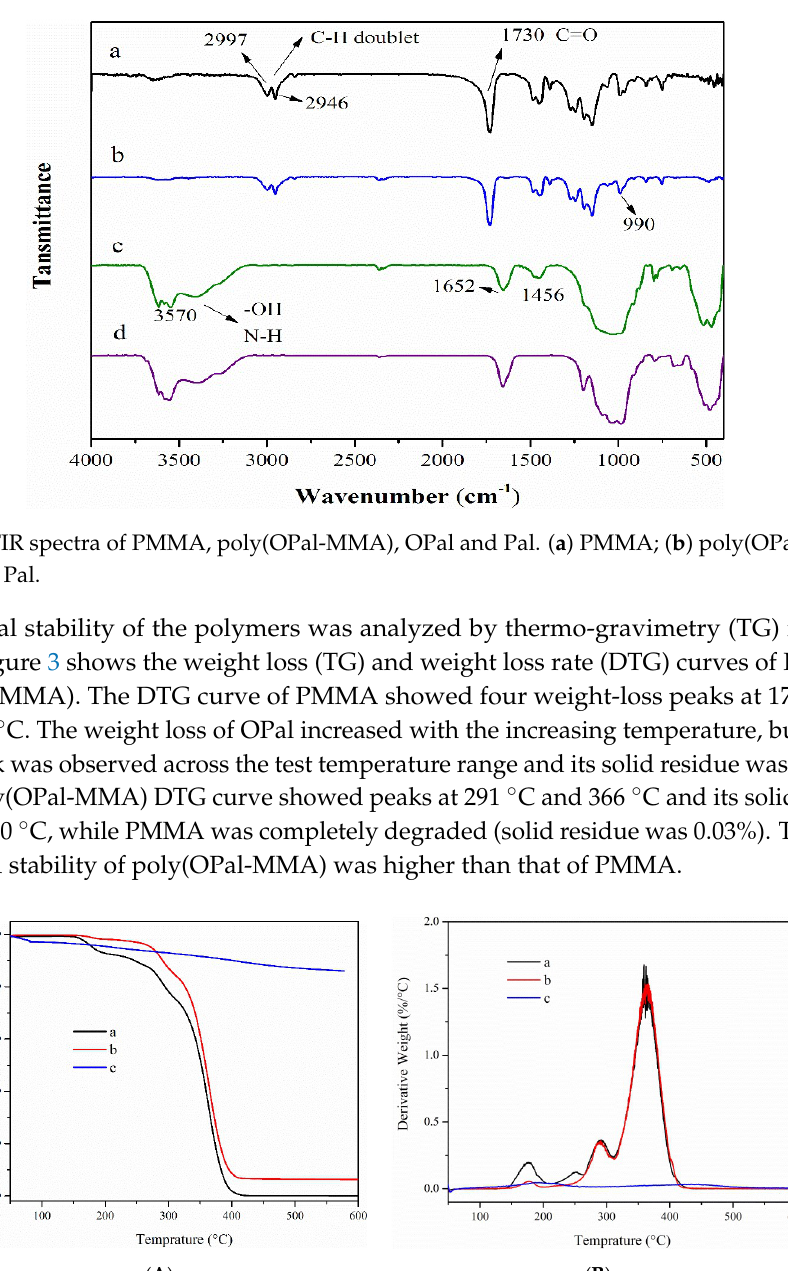
Figure 1. SEM images of poly (methyl methacrylate) (PMMA), poly(OPal-MMA), palygorskite (Pal), and the PMMA/OPal blend. ( a ) PMMA; ( b ) poly(OPal-MMA) (5 wt % OPal); ( c ) OPal; ( d ) PMMA/OPal blend (5 wt % OPal).